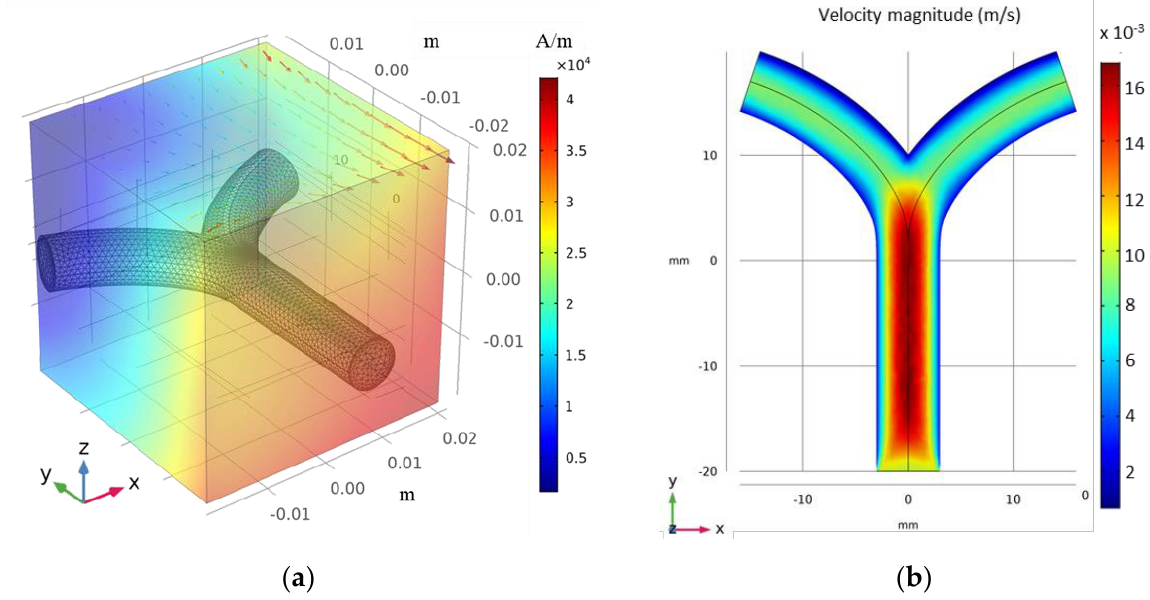
Figure 6. ( a ) Geometrical representation of meshed 3D bifurcation vessel in presence of FFP positioned at ① in the ROI; ( b ) XY projection of fluid velocity in 3D bifurcation vessel.